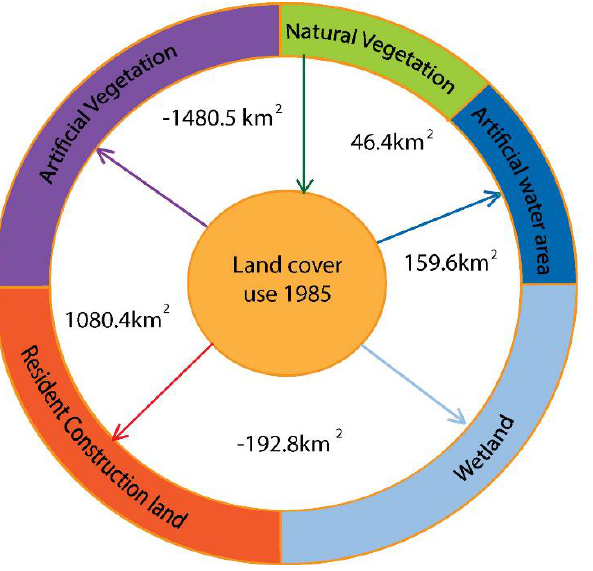
Figure 9. The changes in land cover from 1985 to 2014 are depicted in the diagram. Gains and losses are indicated by arrows. Herein: Pink is a result of human activity, red is a result of temperature rise, yellow is a result of humans and nature, and blue is a result of other natural factors. In this region, climate change may alter the land cover [48]. Large mountains and river basins have different levels of vegetation cover. This demonstrates that the moun- tain and river valley vegetation cover changed between 1985 and 2014 [49]. Additionally, the 2007 average annual temperature overlap was the highest (Figure 10). This is a result of shifting land cover as a result of intense human activity and global warming. Along the river valley, there is also a large amount of agricultural land. In addition, extensive human activity in the region has altered the vegetation cover of the Huai River Basin (Figure 10). The vegetation cover in the river basin will change if there are many people working there [49]. Artificial surfaces and cultivated land have increased as a result of